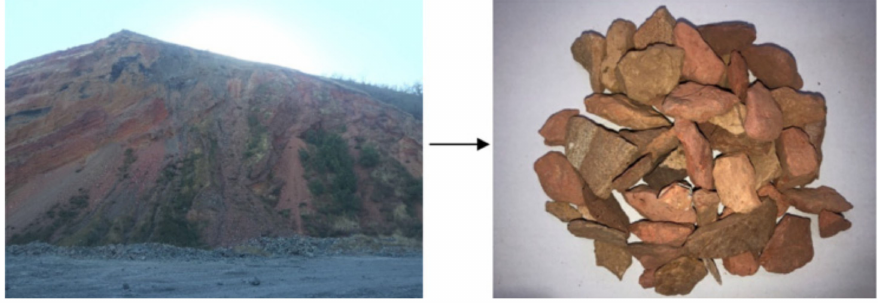
Figure 7. Combustion coal gangue